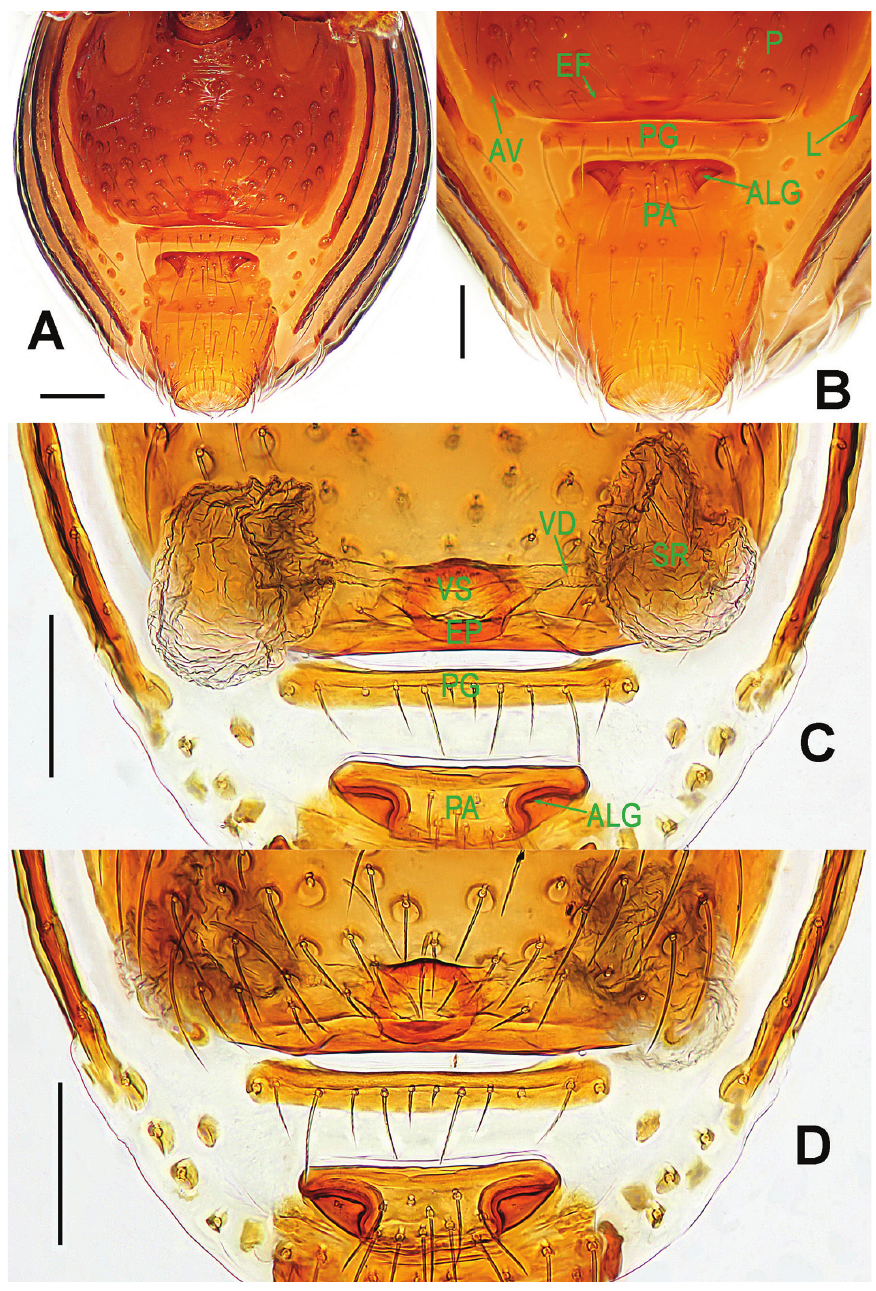
Figure 12. Brignoliella besutensis Lin, Li & Jäger, 2012, female from Singapore. A opisthosoma B genital area (untreated) C cleared vulva (lactic acid-treated) D ditto . A–B, D ventral C dorsal. Abbreviations: ALG = anterolateral groove of preanal plate; AV = anterior ventrolateral plate; EF = epigynal fold; EP = epigynal pit; L = lateral plate; P = pulmonary plate; PA = preanal plate; PG = postgenital plate; SR = seminal receptaculum; VD = vulval duct; VS = vulval stem. Scale bars: 0.10